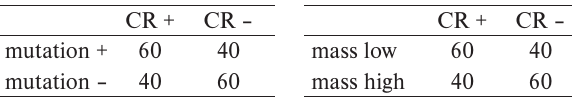
Table 1. Example of two binary variables that have the same values but lead to different